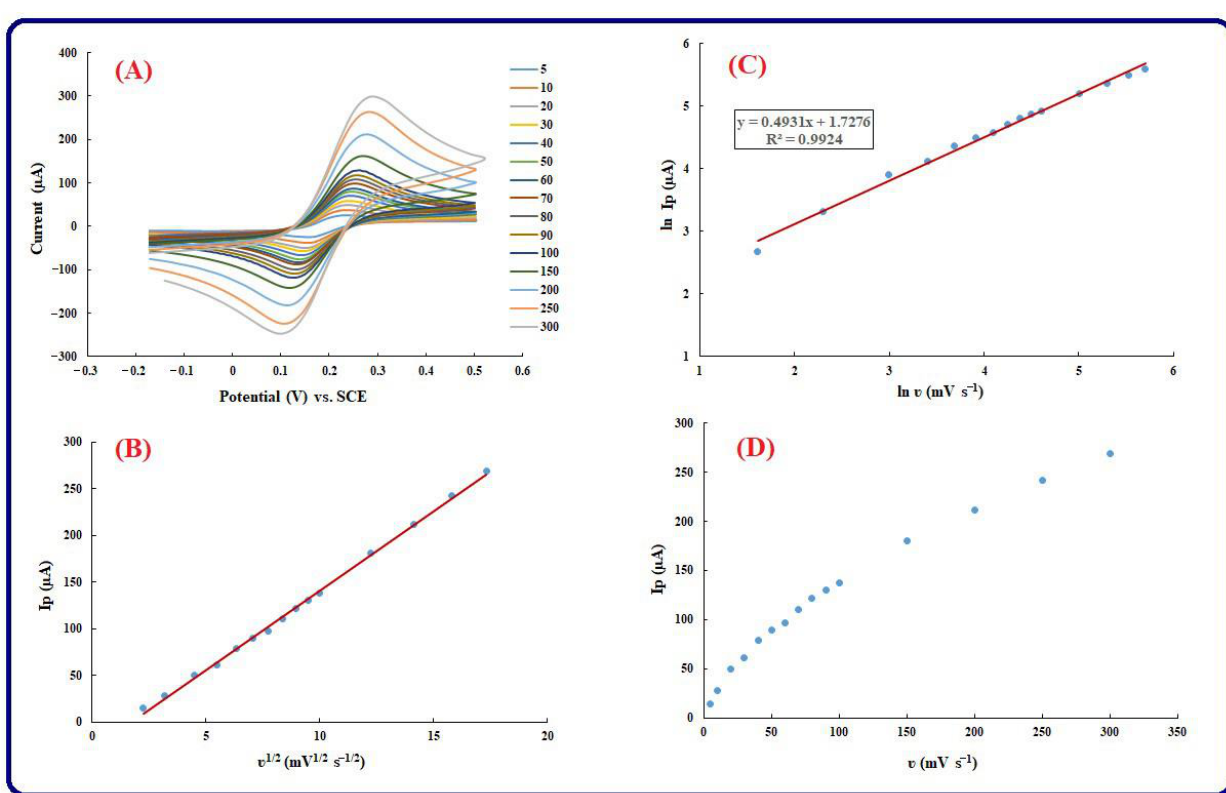
Figure 5. ( A ) CV voltammograms of Perovskite/graphene oxide/AuNPs modified Au electrode in the solution containing Fe(CN) 6 3−/4 - , KCl in various scan rates (10, 20, 30, 40, 50, 60, 70, 90, 100, 150, the solution containing Fe(CN) 6 3 − /4 − , KCl in various scan rates (10, 20, 30, 40, 50, 60, 70, 90, 100, 150, 200, 250, 300 mVs −1 ): [Fe(CN) 6 ] 3−/4− is applied as a supporting electrolyte, ( B ) Plot of Ip (µA) vs. ʋ ½ 200, 250, 300 mVs − 1 ): [Fe(CN) 6 ] 3 − /4 − is applied as a supporting electrolyte, ( B ) Plot of Ip ( µ A) vs. v (V 1/2 . s- 1/2 ), ( C ) Ln Ip (µA) vs. Ln ʋ (mV s −1 ), ( D ) Ip (µA) vs. ʋ ½ (mV 1/2 . s −1/2 ). 1/2 (V 1/2 . s − 1/2 ), ( C ) Ln Ip ( µ A) vs. Ln v (mV s − 1 ), ( D ) Ip ( µ A) vs. v 1/2 (mV 1/2 . s − 1/2